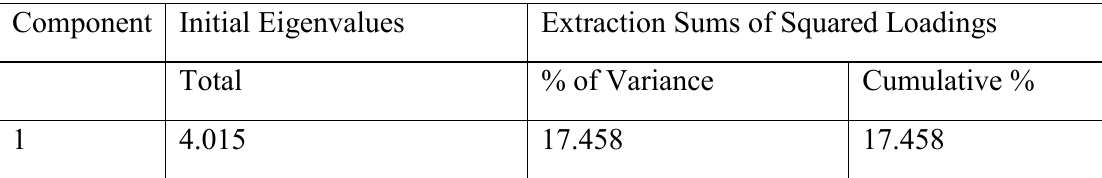
Table 1.40: Variables defining Transformative Resilience PC1